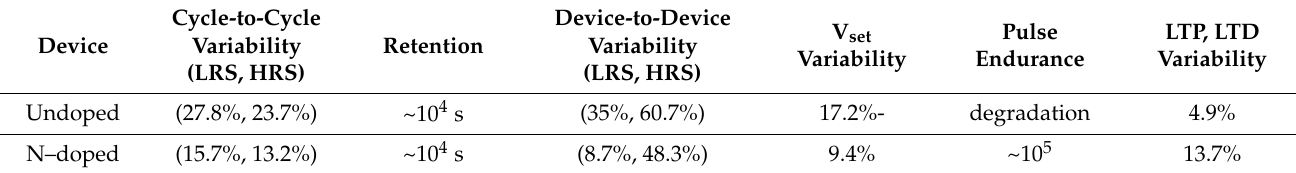
Figure 6. Ta/TaO x /Pt device: ( a ) LTD and LTP are established with 100 identical erase pulses (amplitudes of − 1.09 V, the pulse width of 100 ns) and write pulses (amplitudes of 0.86 V, the pulse width of 100 ns) ( b ) Ten cycles of depression and potentiation (depression first). Ta/TaO x :N/Pt device: ( c ) LTD and LTP are established with 100 identical erase pulses (amplitudes of − 1 V, the pulse width of 100 ns) and write pulses (amplitudes of 0.81 V, the pulse width of 100 ns) ( d ) Ten cycles of depression and potentiation (depression first). Table 3. Key Performance Indicators Achieved in The Present